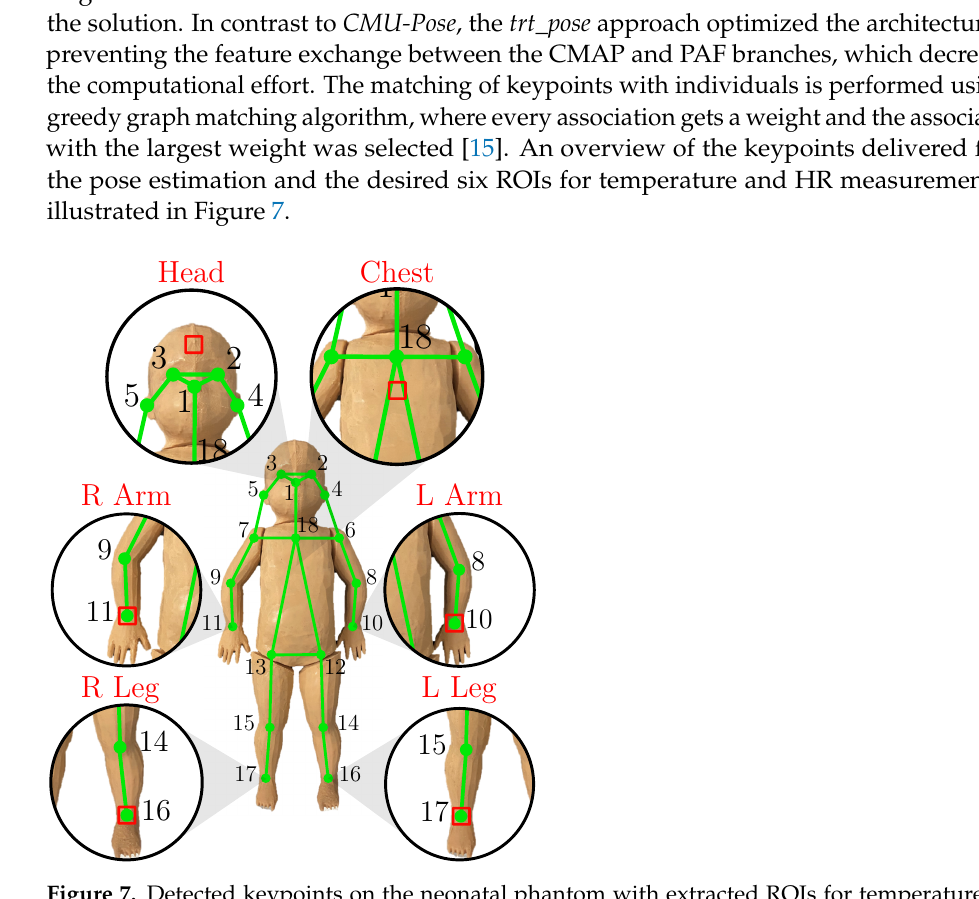
Figure 7. Detected keypoints on the neonatal phantom with extracted ROIs for temperature and HR